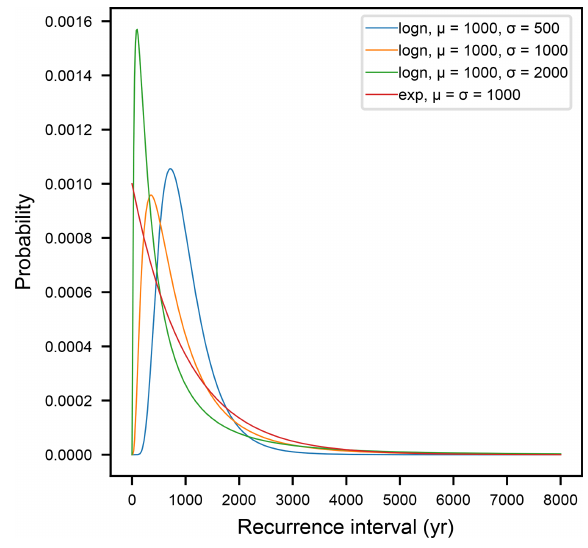
Figure 1. Earthquake recurrence distributions; “logn” represents lognormal; “exp” represents exponential. Colors for each distribu- tion are the same in all